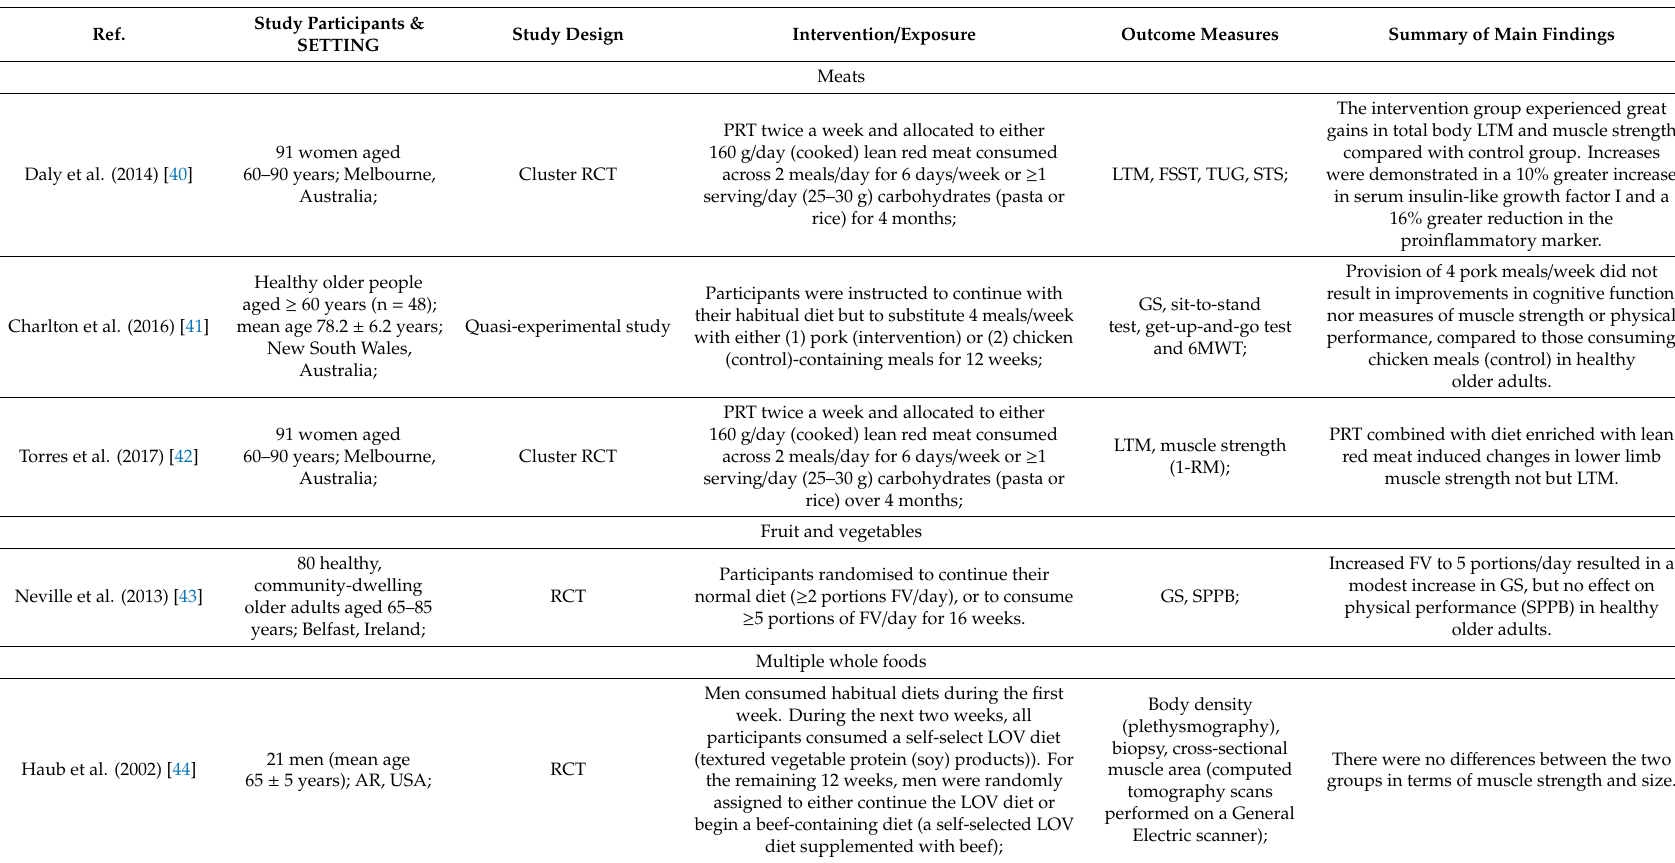
Table 2. Intervention studies involving whole foods and muscle-related outcomes in older adults aged ≥ 50